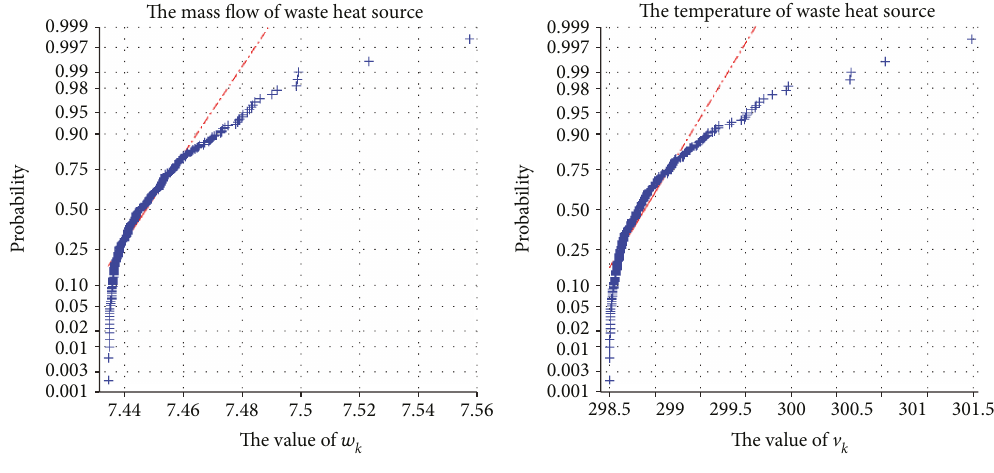
Figure 3: Probability of w